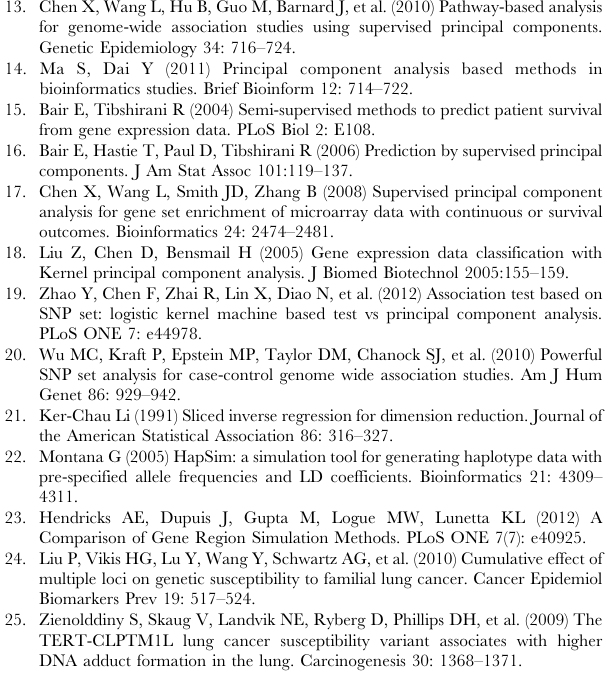
SNPs. Table S5, Test power at the significance level of 0.05 for four methods in Scenarios B10-B11. Table S6, Test power at the significance level of 0.05 for four methods in Scenarios